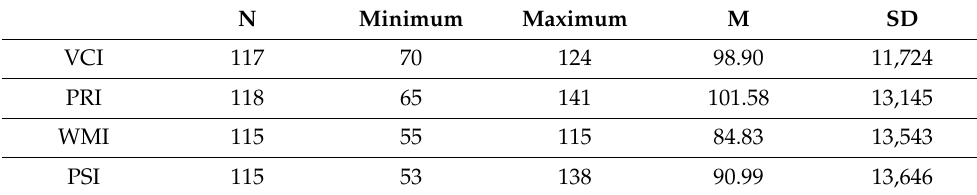
Table 2. Cognitive profile at the Wechsler